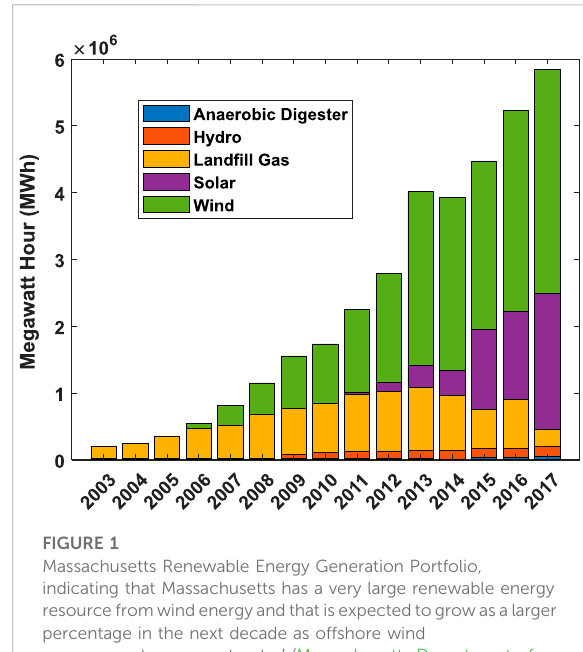
FIGURE 1 Massachusetts Renewable Energy Generation